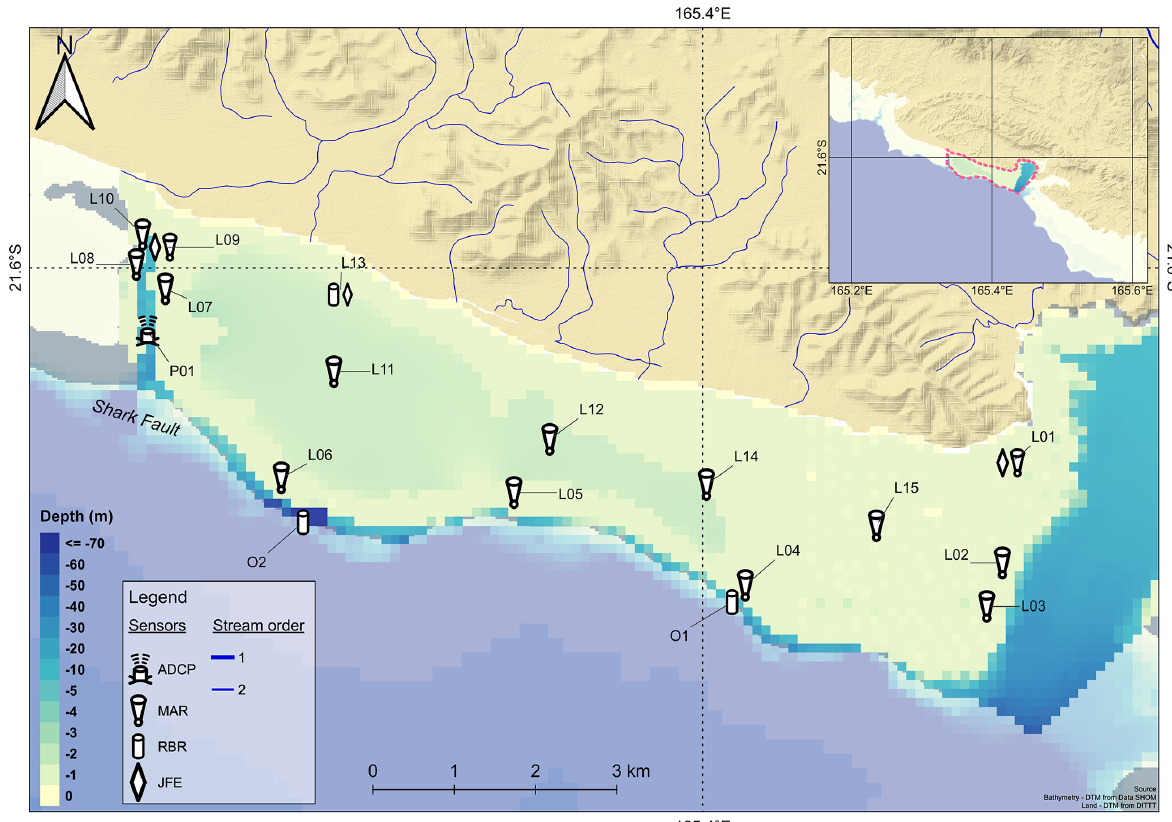
Figure C1. Observational strategy deployed during ELADE field experiment. ADCP: acoustic doppler current profiler; JFE: INFINITY- CTW; MAR: Marotte HS; RBR: RBRduo T.D or RBRduet T.D.